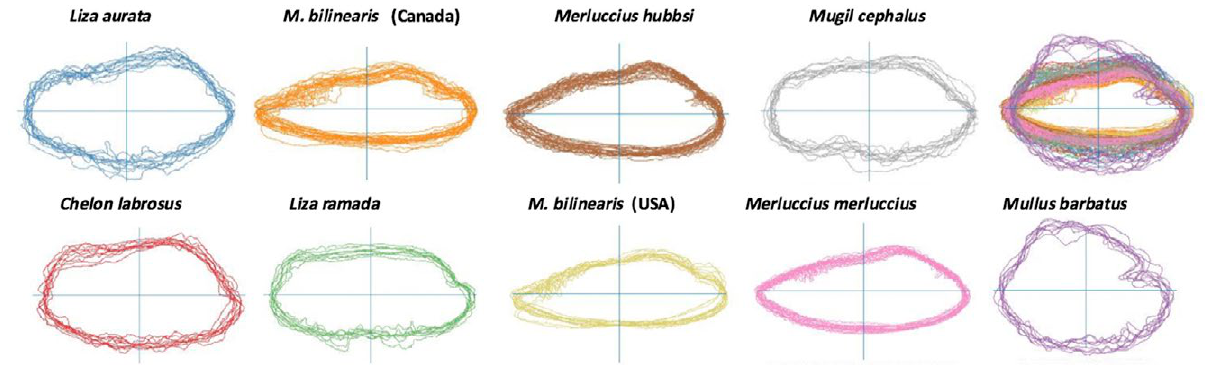
Fig. 1. – Overlapping contours by classes. On the upper-right side, the superposition of all